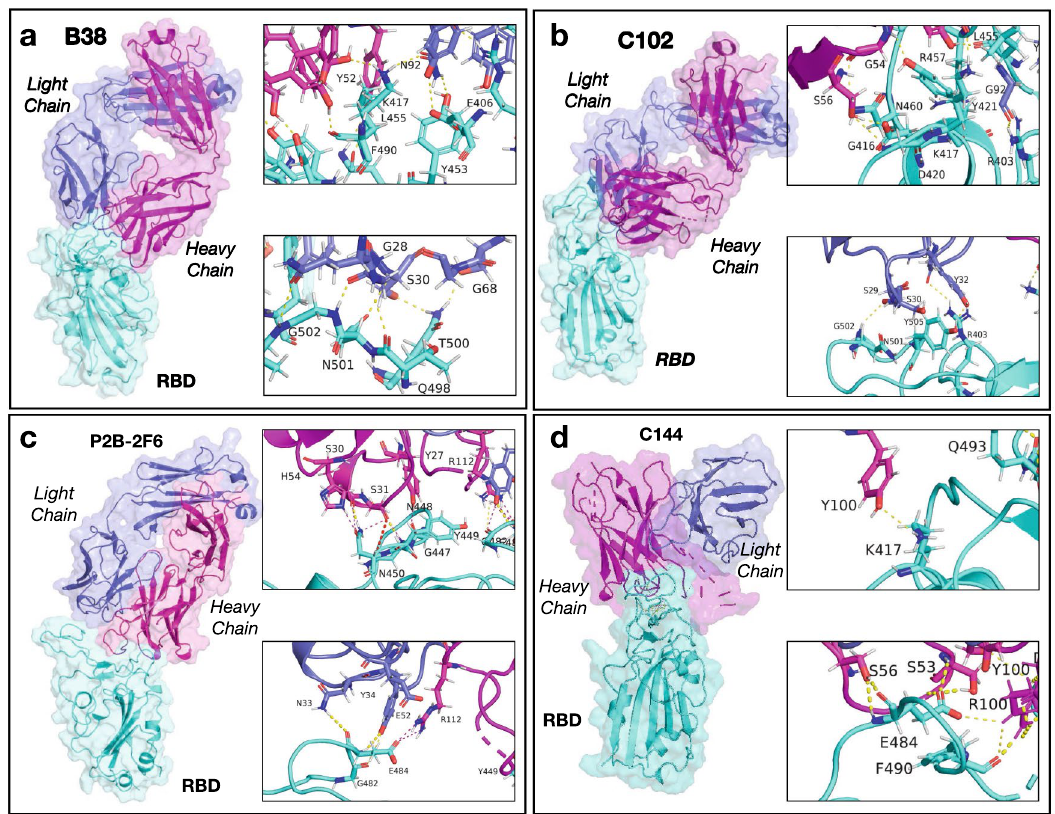
Figure 3. Antibodies Fabs link to the S-protein RBD structure. The RBD is shown in cyan while the HC and LC are shown in magenta and blue, respectively. (a) Structure of B38 and RBD, with the insets show a detailed view of the residues with H-bonds near K417 and N501. (b) Configuration for C102 with residues showing H-bond in the insets near K417 and N501. (c) P2B-2F6 linked to the RBD with residues in contact near N448 and E484. (d) C144 linked to the RBD with residues near K417 and E484